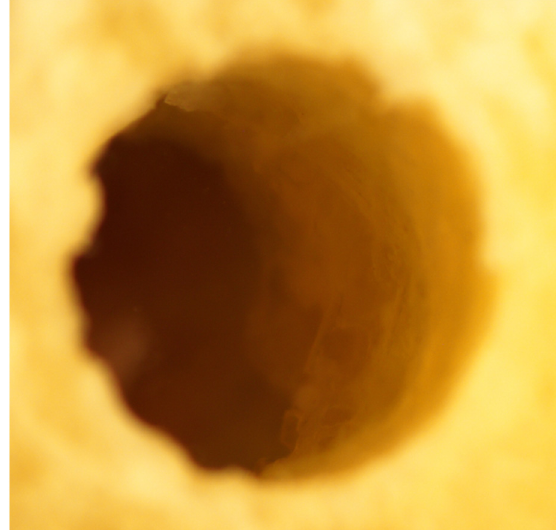
Figure 12. The Densah ® burs’ tibial section in a counterclockwise implant osteotomy preparation under the Nikon ® stereomicroscope, showing condensed and densified bone.